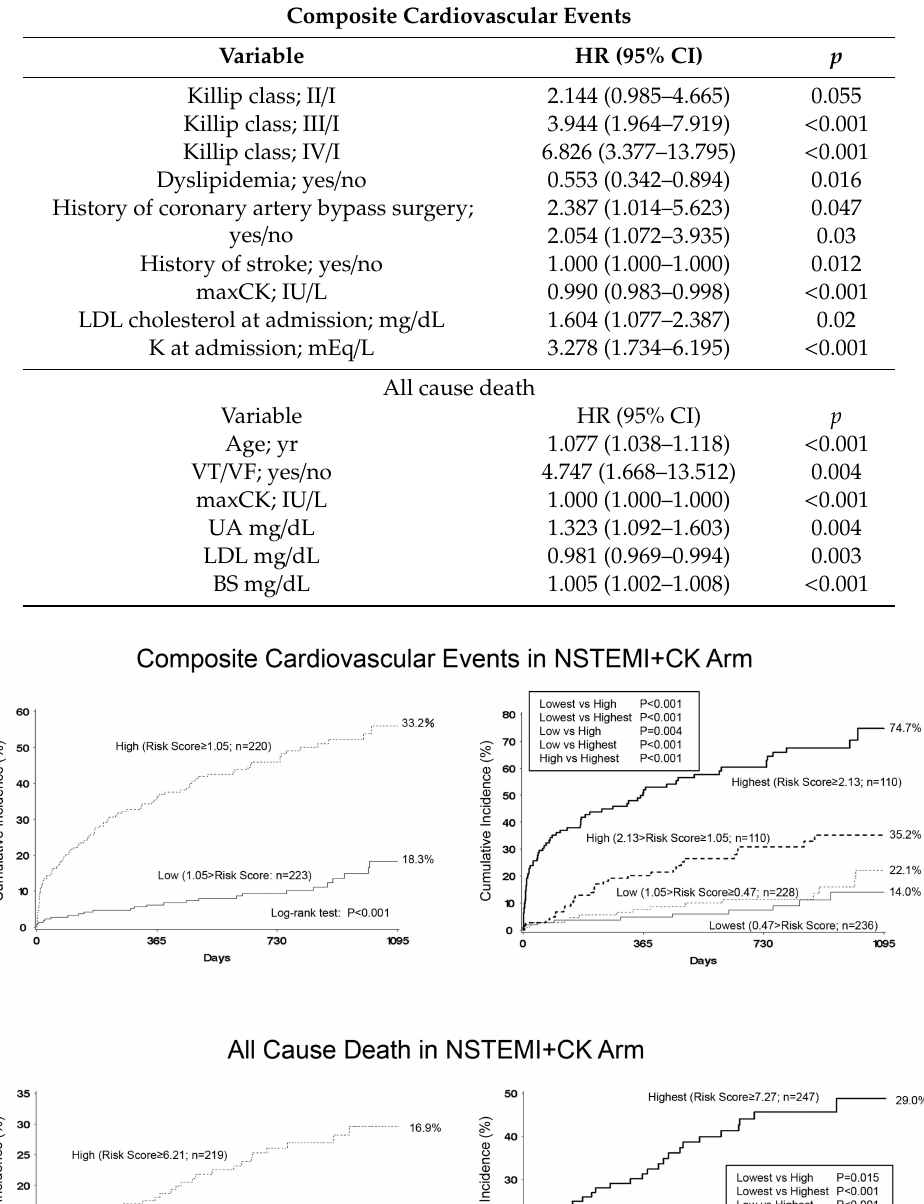
Table 2. Analysis of Cox proportional hazards model with stepwise variable selection for the prediction of adverse events in non-STEMI with elevated creatine kinase (NSTEMI + CK). VF: ventricular fibrillation,